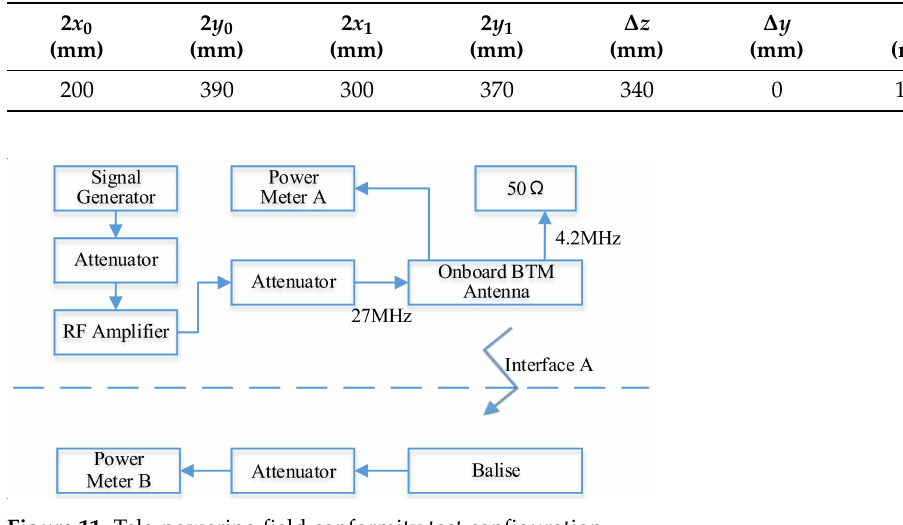
Figure 11. Tele-powering field conformity test